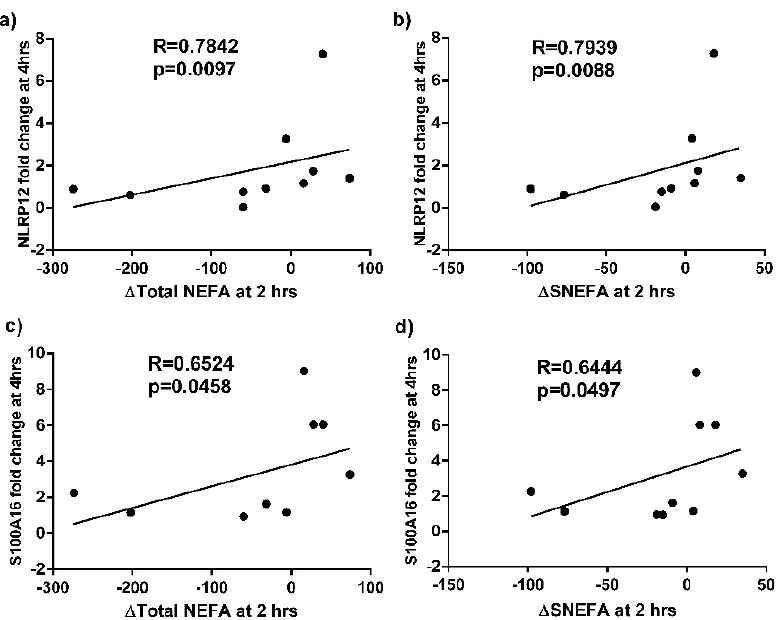
Figure 3. Correlations between the fold change in sputum cell NLRP12 gene expression at 4 h vs. baseline and ( a ) change in ( ∆ ) total non-esterified fatty acids (NEFA)(mg/L) at 2 h vs. baseline; and ( b ) ∆ saturated NEFA (sNEFA)(mg/L) at 2 h vs. baseline, in subjects with asthma. Correlations between the fold change in sputum cell S100A16 gene expression at 4 h vs. baseline and ( c ) ∆ Total NEFA (mg/L) at 2 h vs. baseline; and ( d ) ∆ sNEFA (mg/L) at 2 h vs. baseline, in subjects with asthma.